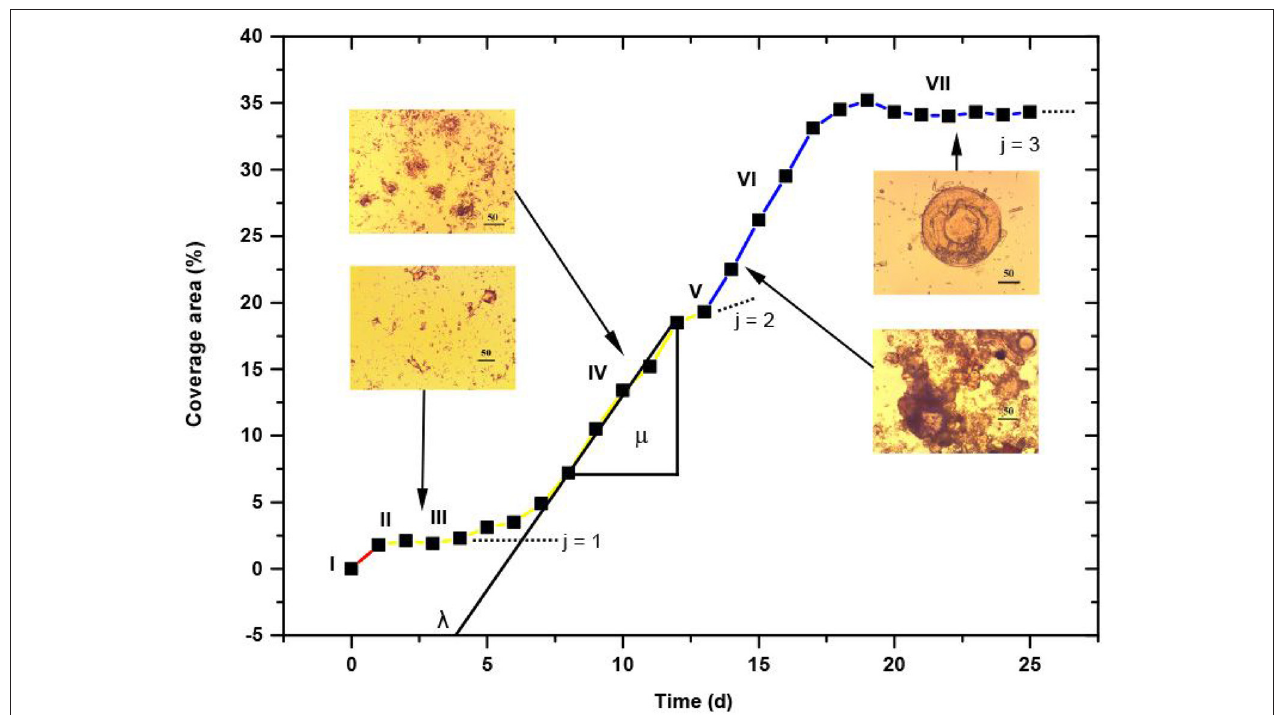
FIGURE 8 | Marine biofilm growth curve (coverage area fraction vs. time) fitted with three Gompertz functions. Red, orange and blue line parts correspond to the main stages of biofilm establishment. I-VII seven main phases of biofilm formation dynamics. Microscopic images of four characteristic stages of the growth phases (Magnification 400 x, bars correspond to 50 µ m) are shown as insets.